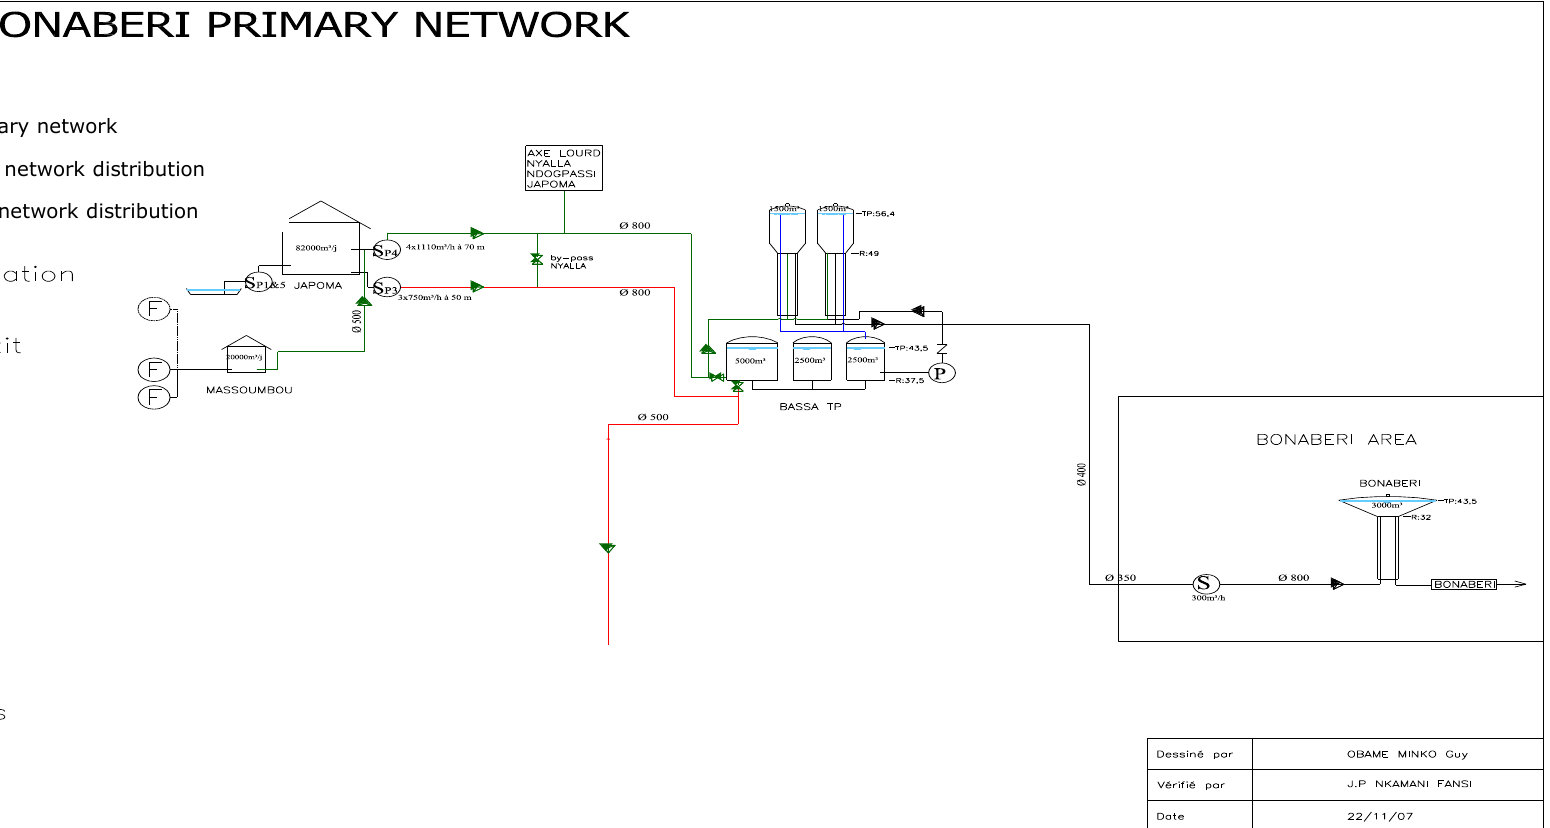
Figure 1. Overview diagram of the Bonabri-primary network. Extracted from the CDE